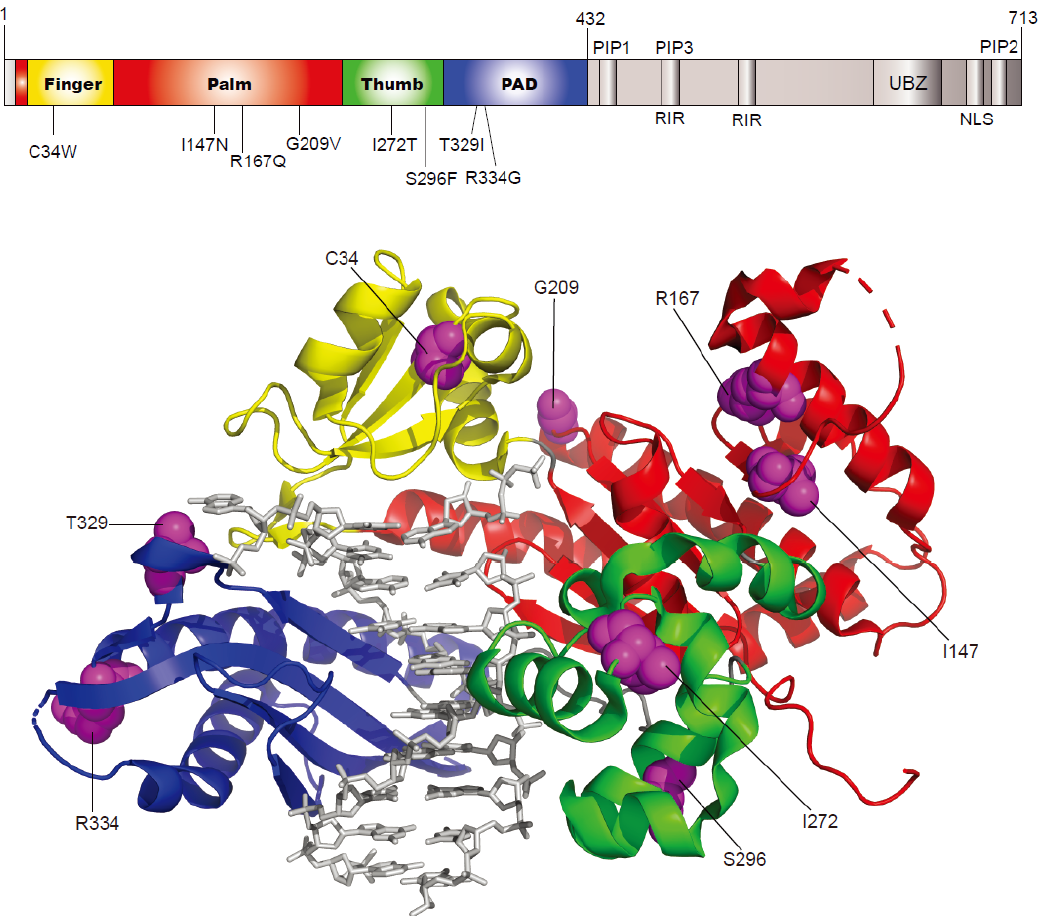
Figure 1. Locations of POLH gene variants. The structure (PDB code, 3MR2) of human pol η (1—432) (shown as ribbons) bound to primer/template DNA and incoming nucleotide (shown as gray sticks) is drawn using PyMOL (http://www.pymol.org (accessed on 8 September 2020)). The finger, palm, thumb, and PAD domains are colored yellow, red, green, and blue, respectively. The eight variant residues are indicated in the upper schematic domain diagram and shown as purple spheres in the structure.